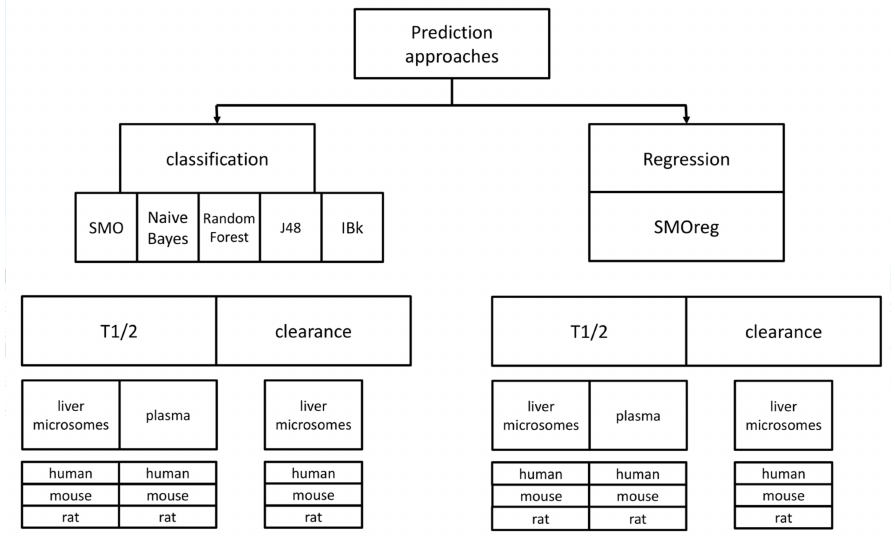
Figure 6. Scheme of the prediction approaches covered in the